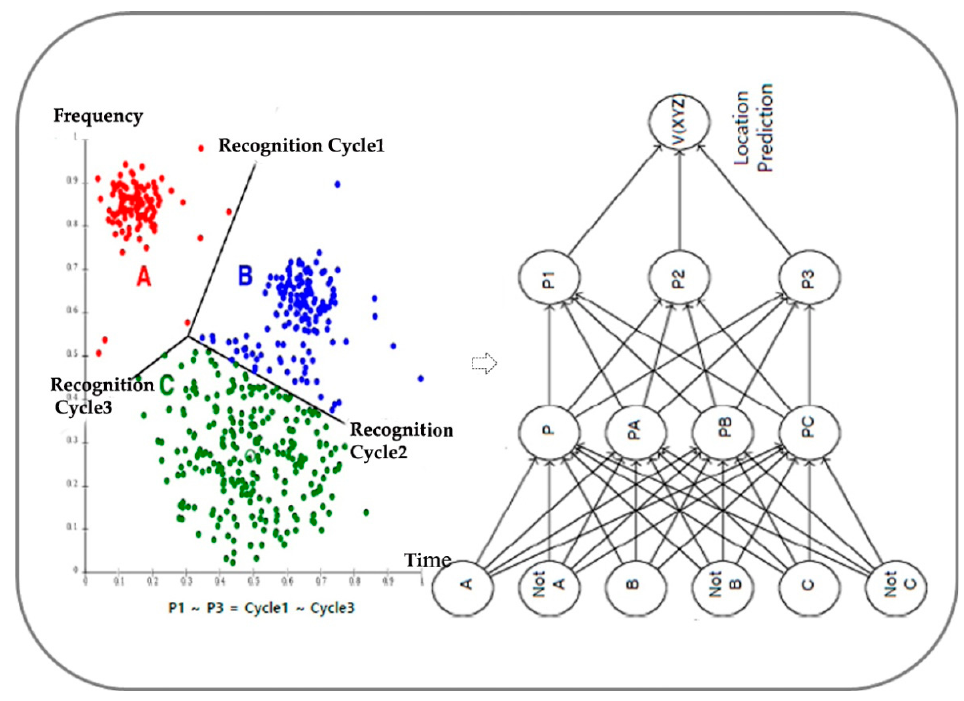
Figure 5. Learning methodology for tagging